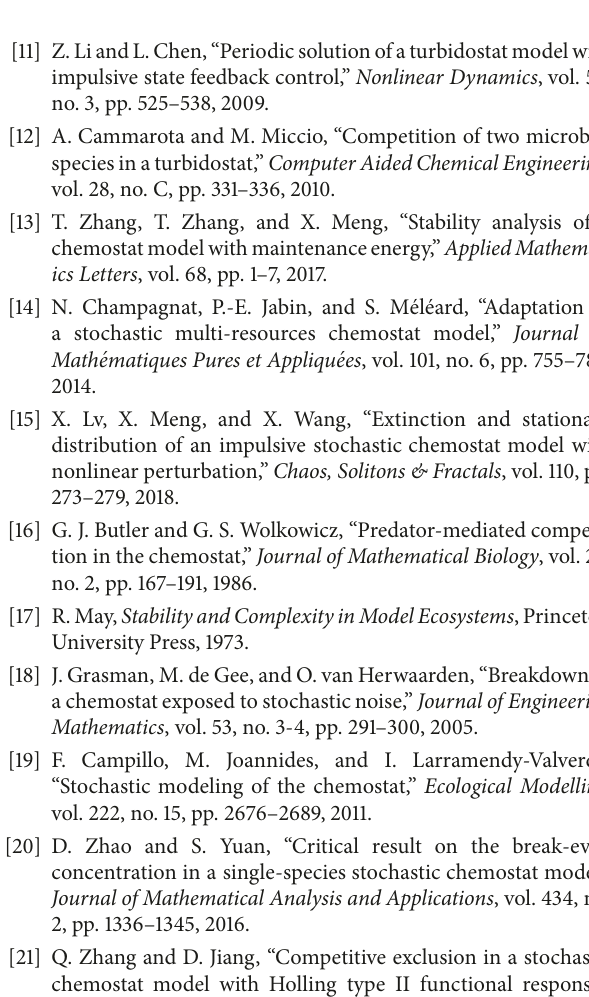
Figure 6: 𝑥 1 and 𝑥 2 die out for system (117) with initial value 𝑆(0) = 0.5 , 𝑥 1 (0) = 𝑥 2 (0) = 0.3 . (a) and (b) are the time series of system with different time